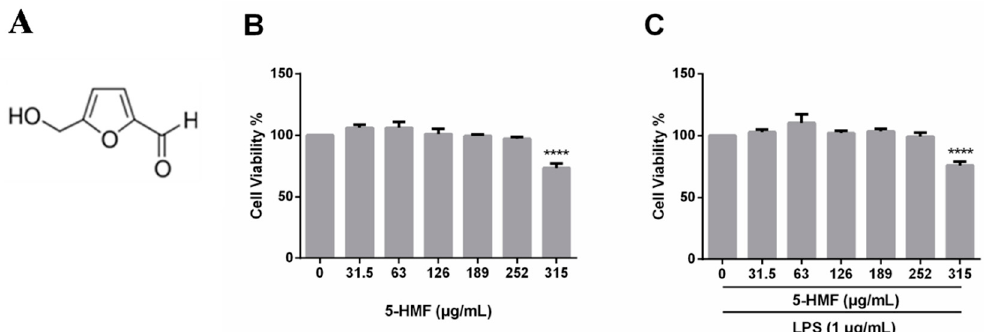
Figure 1. Cell viability of 5-HMF. ( A ) The chemical structure of 5-hydroxymethylfurfural. ( B ) Effects of 5-HMF on the cell viability in RAW 264.7 cells. Cells were treated with various concentrations of 5-HMF for 24 h, followed by the MTT assay. ( C ) Effects of 5-HMF in the presence of LPS on the cell viability in LPS-induced RAW 264.7 cells. Cells were treated with various concentrations of 5-HMF for 6 h and then further treated with LPS (1 µ g/mL) for 24 h. The data are expressed as means ± SDs (n = 3). ****: P < 0.001, as compared with the blank control